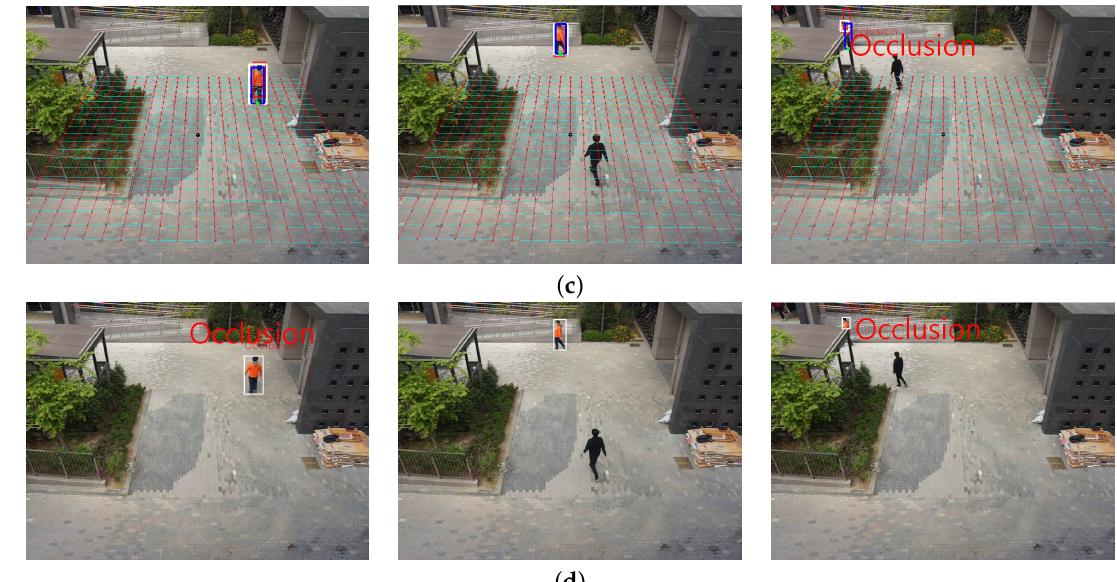
Figure 10. Results of occlusion detection three selected frames in each video: ( a ) occlusion by background; ( b ) occlusion by another object; ( c ) result of occlusion detection detection in another video and ( d ) result occlusion detection without depth